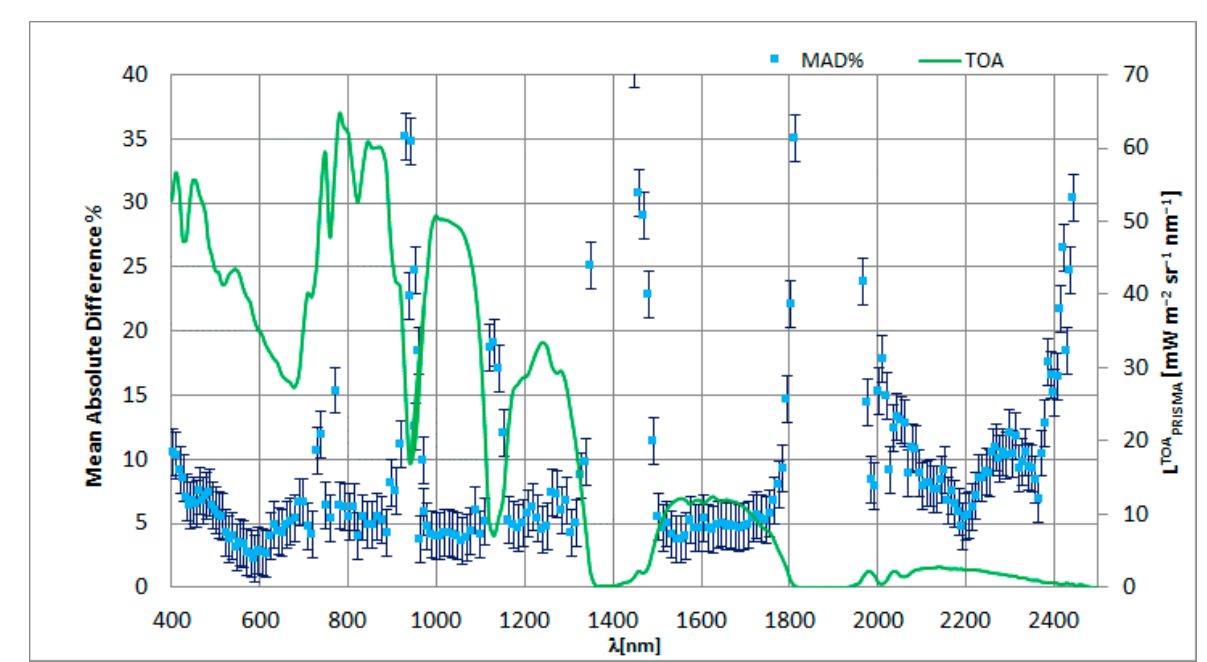
Figure 6. RMAD values calculated for the PRISMA L1 and 𝐿 (cid:3002)(cid:3020)(cid:3005)(cid:3021)(cid:3016)(cid:3002) . Standard deviation is depicted as vertical bar. The green line corresponds to the 𝐿 (cid:3017)(cid:3019)(cid:3010)(cid:3020)(cid:3014)(cid:3002)(cid:3021)(cid:3016)(cid:3002) of a homogeneous vegetation canopy target in the area as reference.